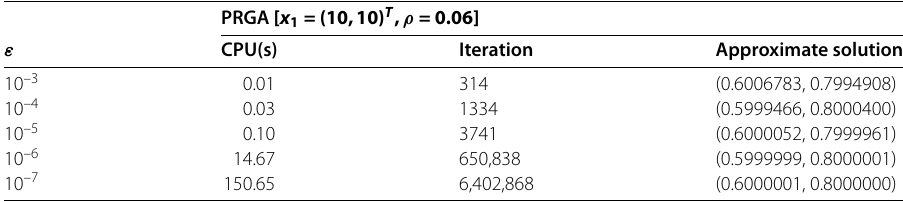
Table 2 Numerical results for Example 5.1